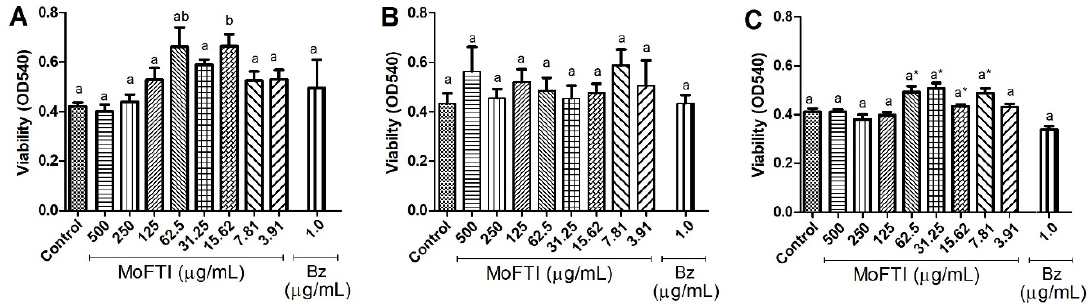
Figure 3. Effects of M. oleifera flower trypsin inhibitor (MoFTI) and benznidazole (Bz) on the viability of human peripheral blood mononuclear cells (PBMCs) after exposure by 24 h ( A ), 72 h ( B ), and 120 h ( C ). Different letters (a,b) indicate significant differences between the negative control and the other treatments by analysis of variance (ANOVA) followed by the Kruskal–Wallis test ( p < 0.05). The asterisk (*) indicates significant differences between Bz and the other treatments. Control: negative control (untreated cells).